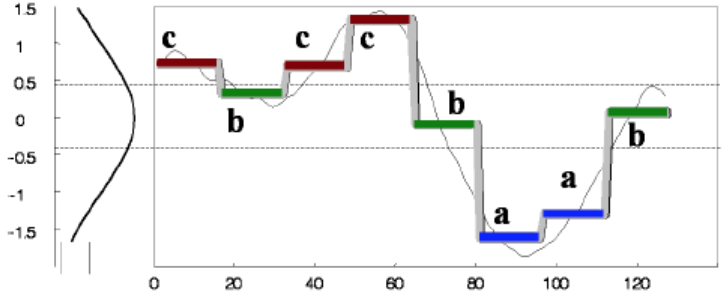
Figure 1. Example Symbolic Aggregate Approximation (SAX) method to take a symbolic representation of a time series. Dimensionality reduction via Piecewise Aggregate Approximation (PAA). The symbolic representation is: baabccbc [15].